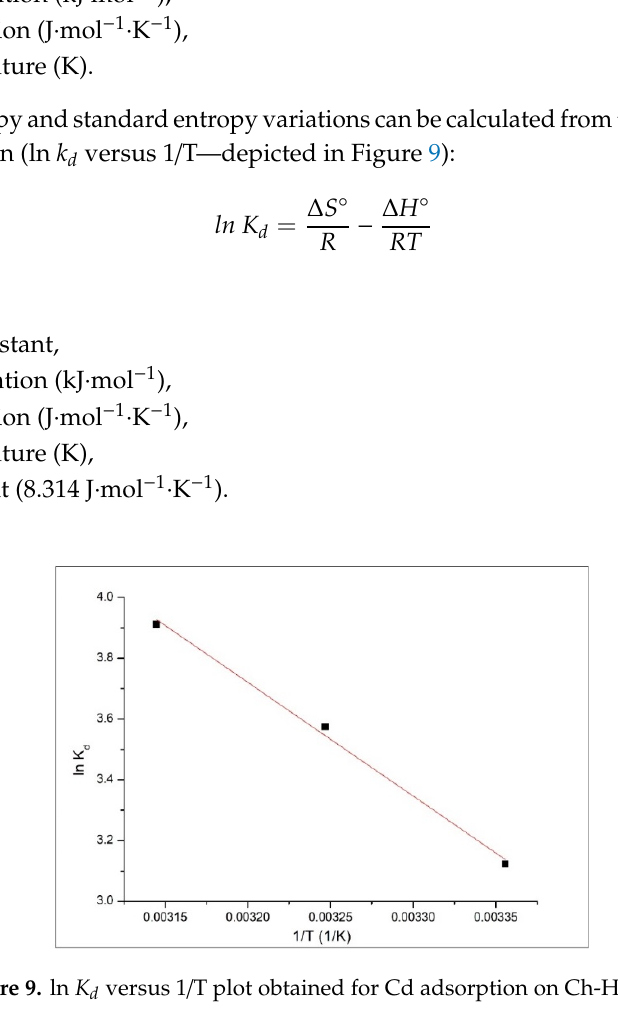
Table 4. Thermodynamic parameters for adsorption of cadmium (II) on the functionalized material.